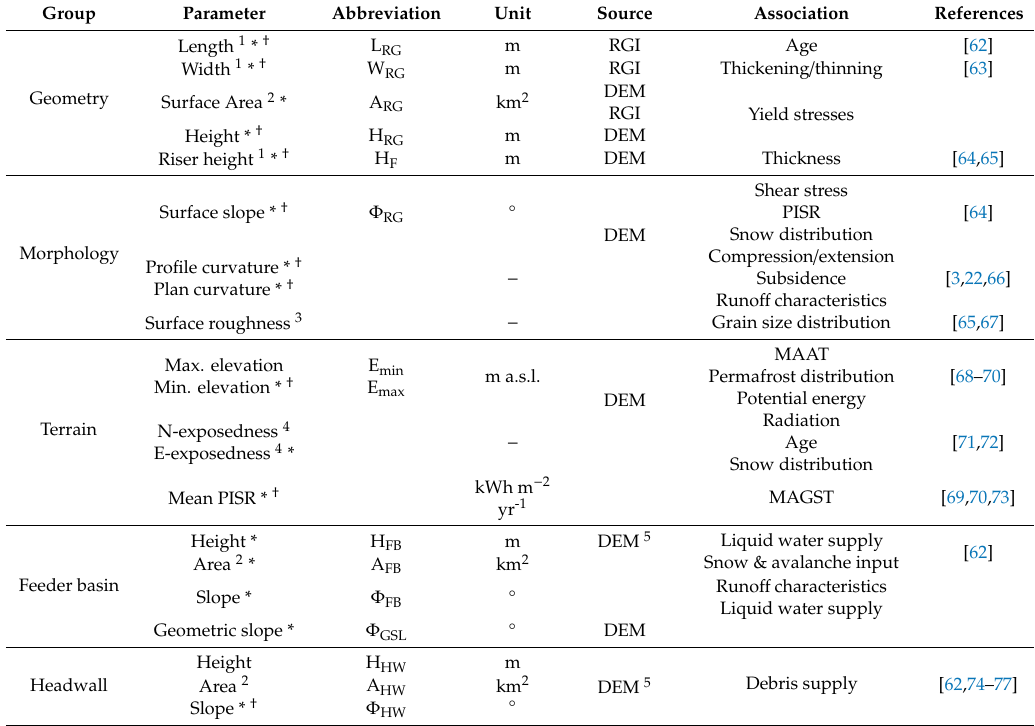
Table 2. Potential geometric, morphometric and topoclimatic parameters controlling rock glacier activity and surface velocities. All parameters are derived from a 5 m digital elevation model (DEM) and the polygon-based rock glacier inventory